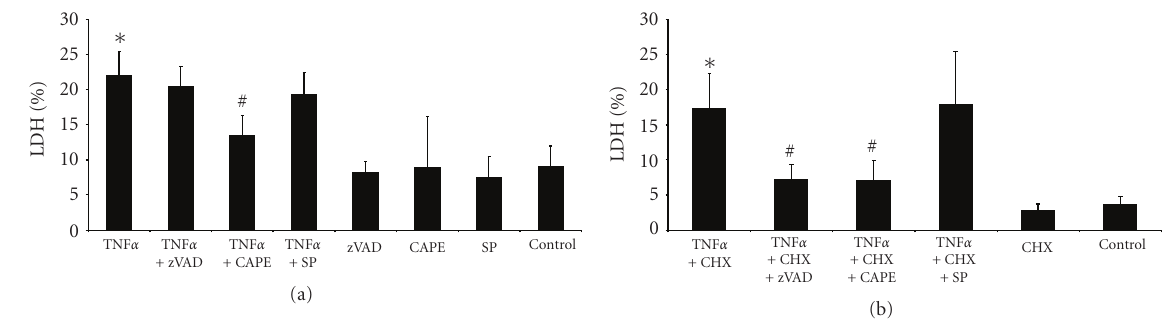
Figure 7: Inhibition of NF- k B induction attenuates PCPEC cytotoxicity. Cytotoxicity in the presence of TNF α (100 ng/mL) ± cycloheximide (CHX) (1 μ g/mL) ((a) and (b)) for 24 hours, was detected by measuring LDH activity in the supernatant. Cytotoxicity inhibition experiments in PCPEC cells were performed after preincubation with zVAD-fmk (10 μ M), CAPE (5 μ M) or SP600125 (10 μ M) for 2-hour. The data are expressed as the percentages of cytotoxicity in treated wells compared with cytotoxicity in control wells with PCPEC alone. The data shown are mean ± SEM of three independent experiments, each performed in duplicate. ∗ P-value of < . 05 compared to unstimulated PCPEC; # P-value of < . 05 compared to TNF α ± CHX stimulated PCPEC without